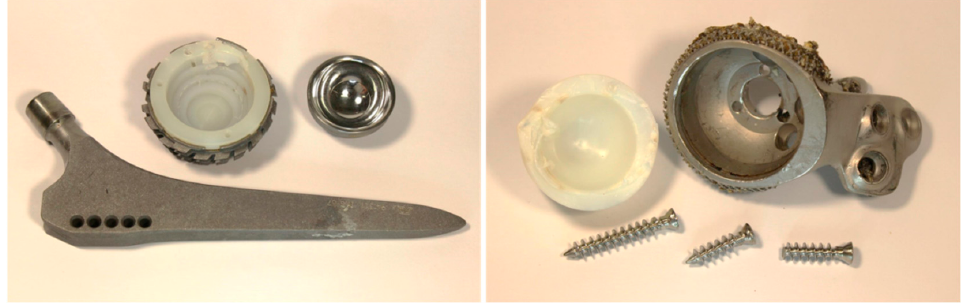
Figure 4. Examples of revised total hip implant systems.